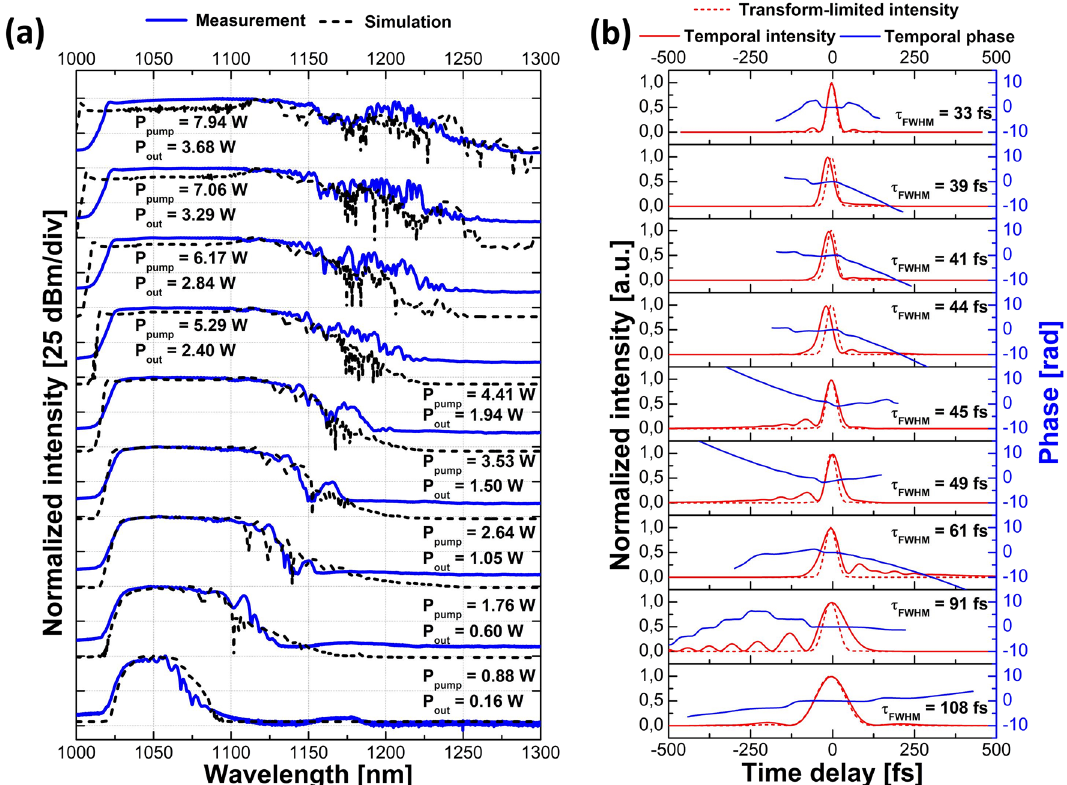
Figure 6. Characterization of the amplified pulses for the low-repetition-rate laser source: ( a ) comparison of the simulated spectra at the output of the amplifier (dashed black line) and traces measured with the OSA (solid blue line) with the corresponding pump powers and average output powers after the amplifier; ( b ) FROG- retrieved temporal intensity (solid red line) of the compressed pulses together with temporal phase (solid blue line), transform-limited intensity (dashed red line) and the corresponding pulse duration.